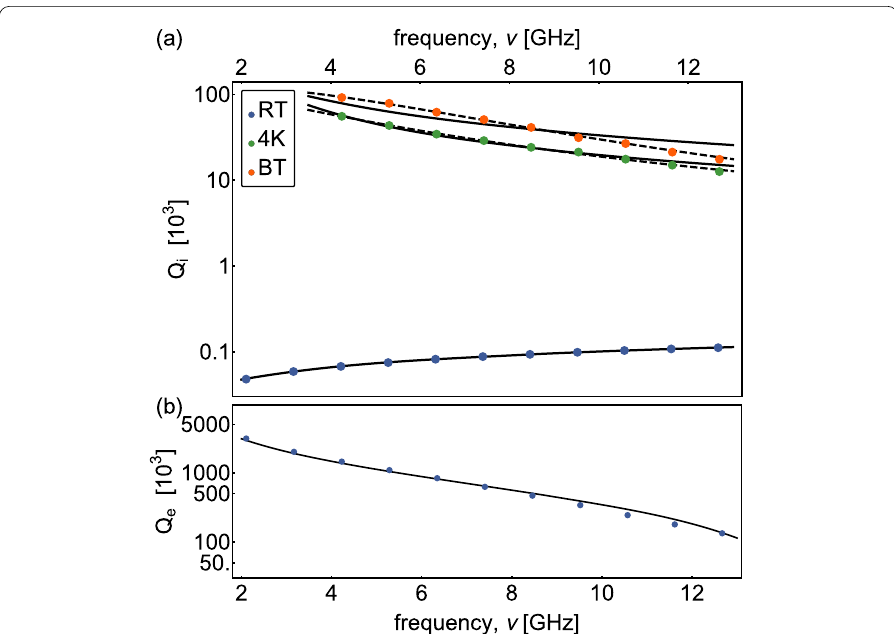
Figure 5 Frequency and temperature dependence of quality factors of niobium-titanium coaxial line CC085NbTi. (a) Measured ( Q i ) internal and (b) external quality factors ( Q e ) of coaxial line CC085NbTi versus frequency ν extracted from the spectra at RT (blue dots), at 4K (green dots) and BT (orange dots). The solid (dashed) black lines are fits to the loss model which assumes R sc s ( ν ) ∝ ν 2 ( R sc s ( ν ) ∝ ν p